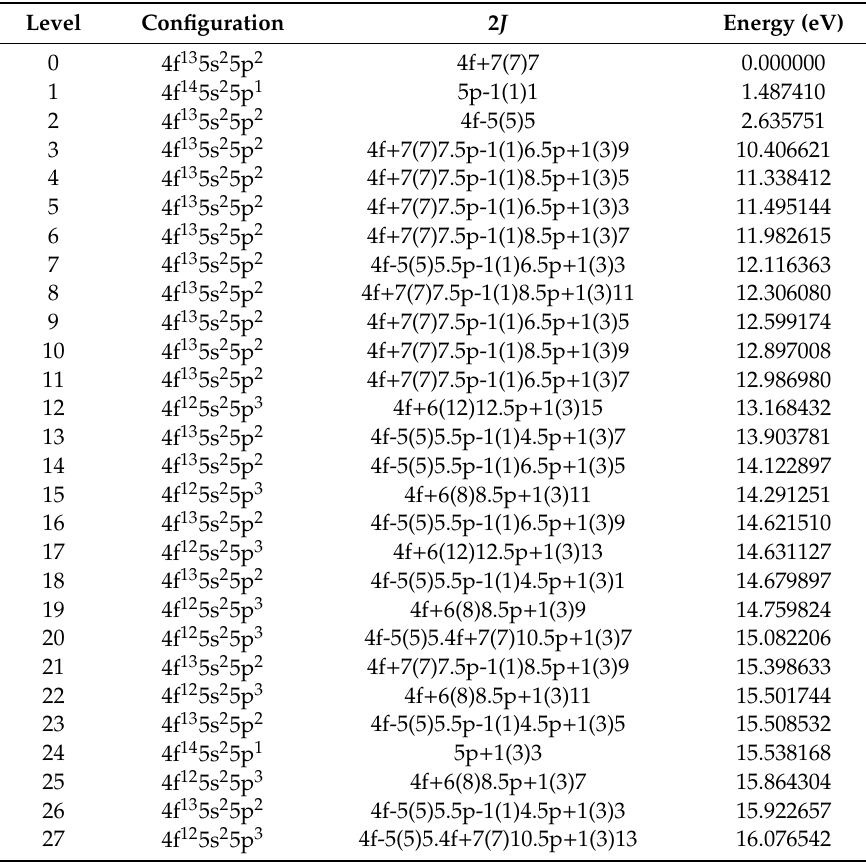
Table 1. Energies (in eV) of 304 lowest levels of Eu-like